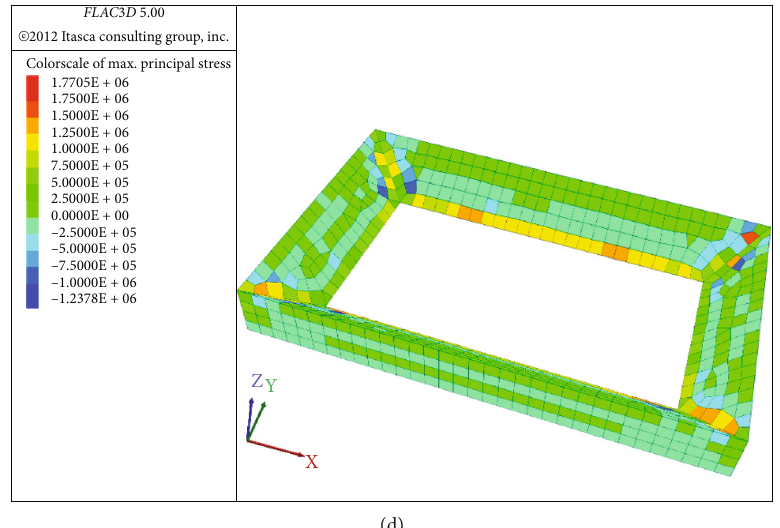
Figure 5: Cloud diagram of maximum principal stress of unreinforced boat pond at di ff erent advancement distances: (a) advance 250m; (b) advance 500m; (c) advance 750m; (d) advance